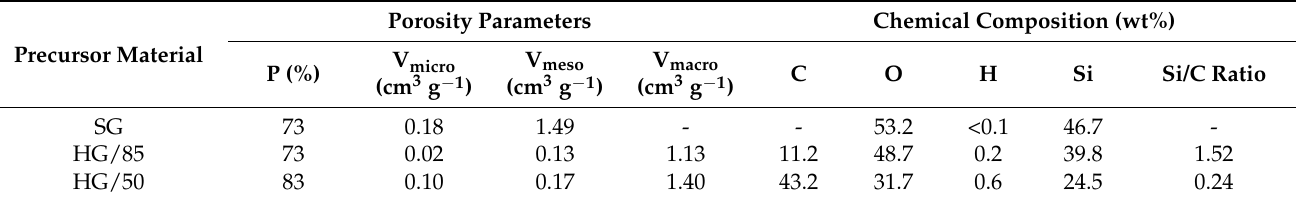
Figure 2. N 2 adsorption-desorption isotherms at 77 K of sol-gel materials. Table 2. Porous properties and chemical composition of silica and C-Si hybrid gels.